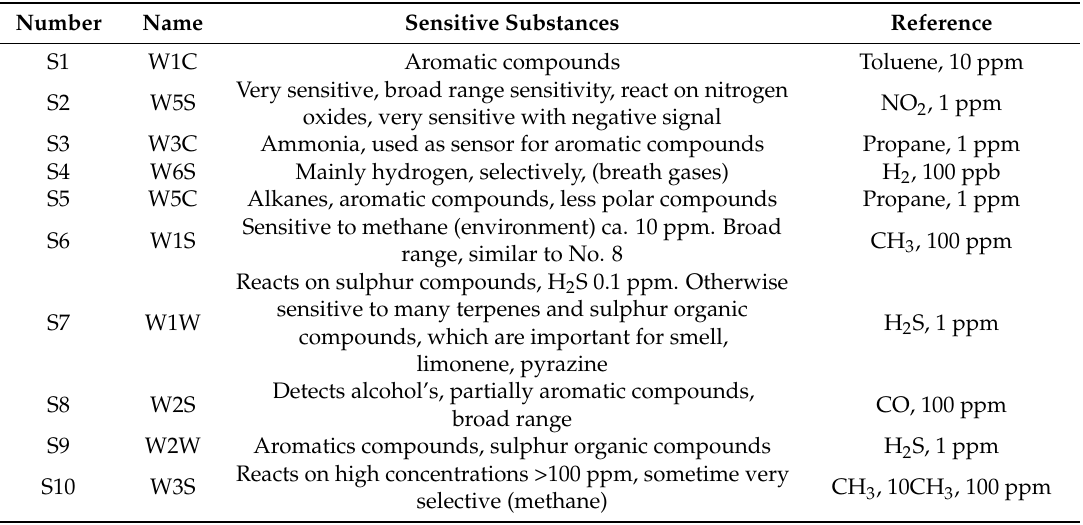
Table 1. Sensors in PEN3 E-nose system and their sensitivity